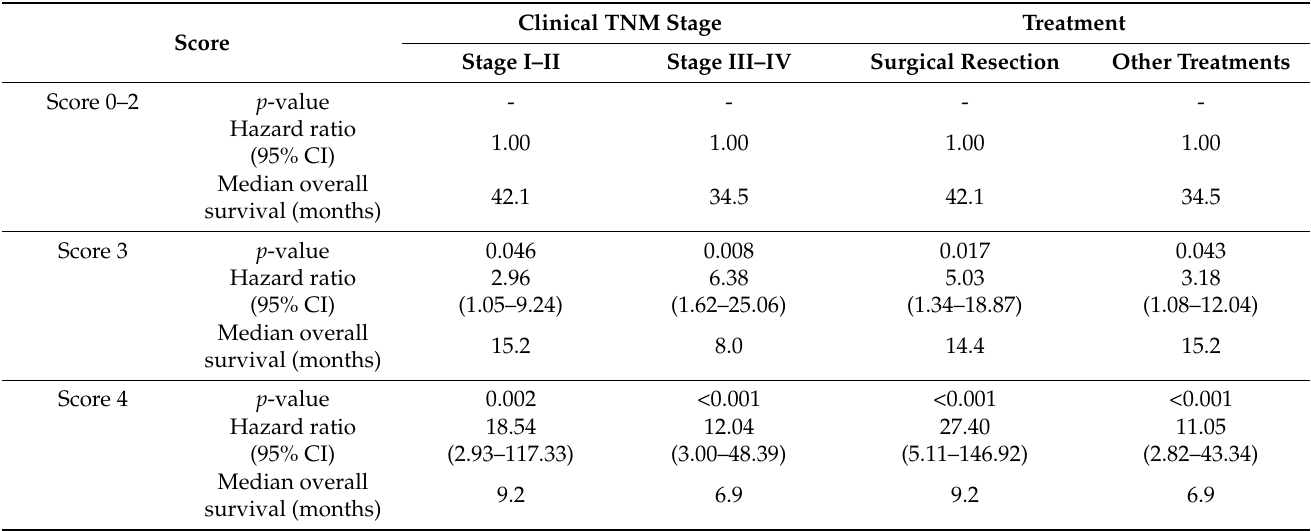
Table 5. Prognostic values of the PET/CT scoring system in subgroup analysis of overall